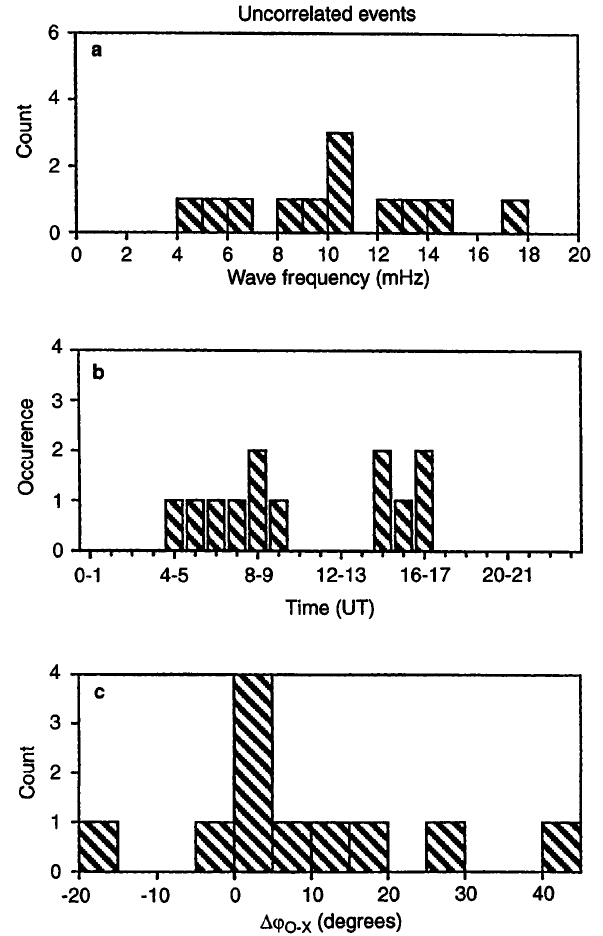
Fig. 3a–c. Characteristics of the uncorrelated wave signatures for the 12events: a ULFwavefrequency, b diurnaloccurrenceand c D u